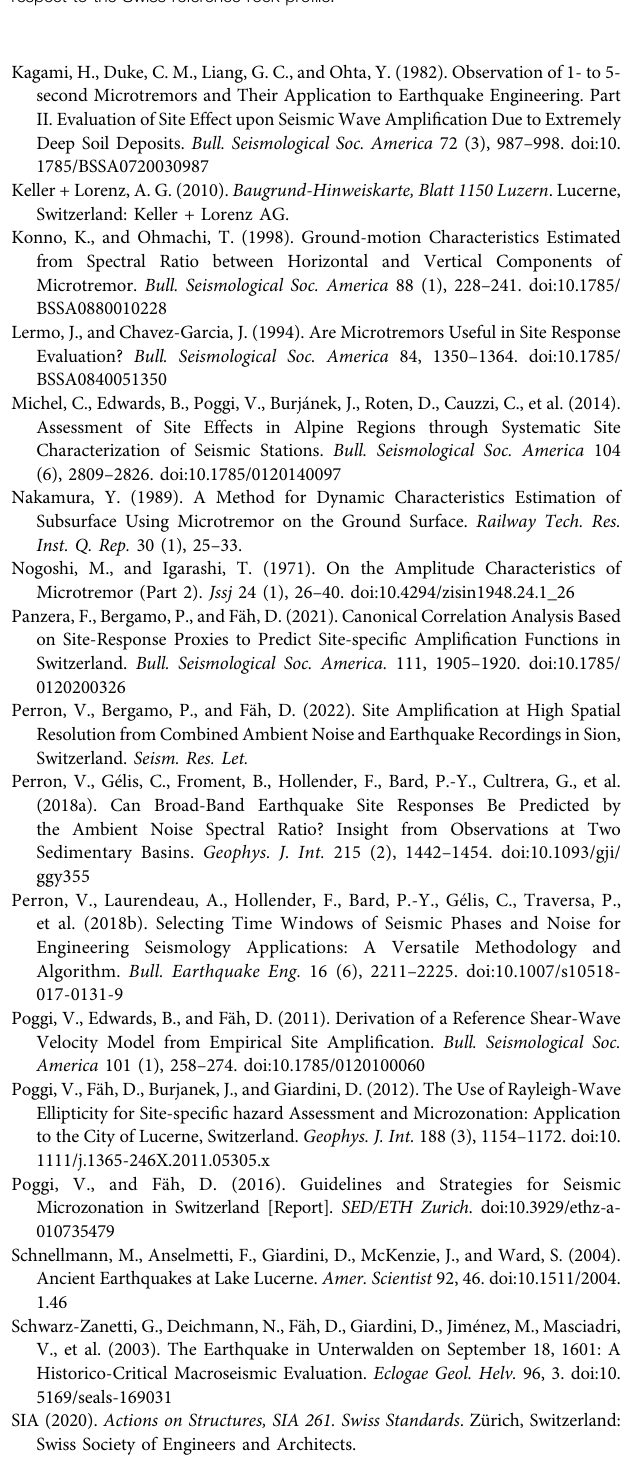
functions for stations of the temporary network are shown outside the